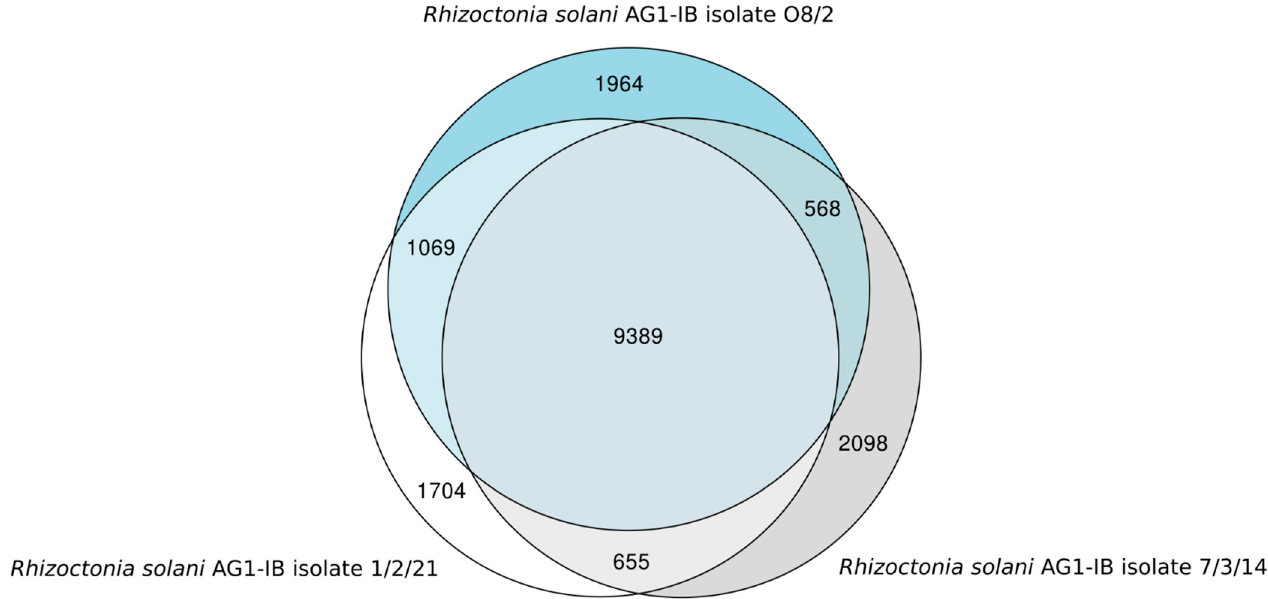
Figure 2. Euler diagram of the gene-based genome comparison for the completely sequenced R. solani AG1-IB iso- lates. The core genome of all isolates consists of 9389 genes. These genes are present in the genomes of all sequenced R. solani AG1-IB isolates: O8/2 [EMBL-EBI: CAJZAE010000001-CAJZAE010001402], 1/2/21 [EMBL-EBI: CAJZAD010000001- CAJZAD010002093] and 7/3/14 [EMBL-EBI: CDGK01000001–CDGK01018395 (Contigs); LN679100–LN679996 (Scaffolds)]. For computation of the Venn diagram, default settings of EDGAR 3.0 [34–36] were applied.